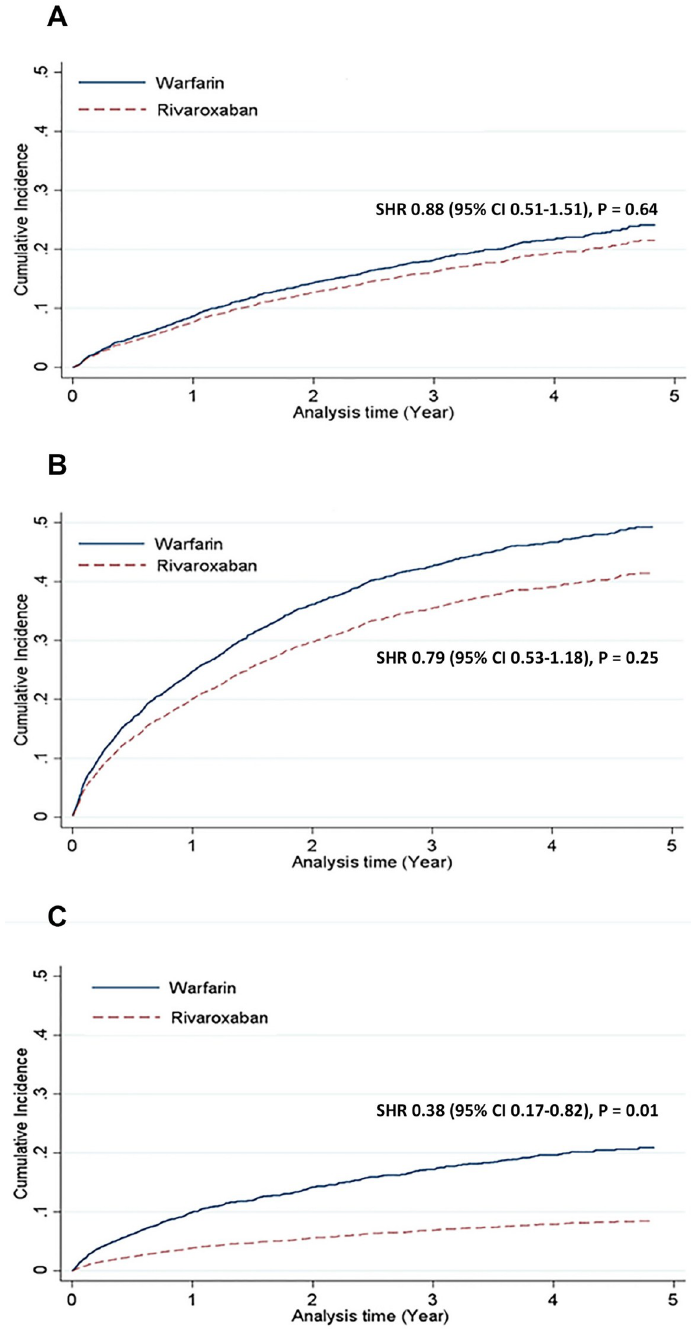
Fig 2. Bleeding and thromboembolic outcomes: Rivaroxaban versus warfarin. Compared with warfarin users, rivaroxaban users were associated with similar risks of major bleeding (A) and non-major clinically relevant bleeding (B), but a lower risk of ischemic stroke or systemic embolism (C). CI = confidence interval; SHR = subdistribution hazard ratio.